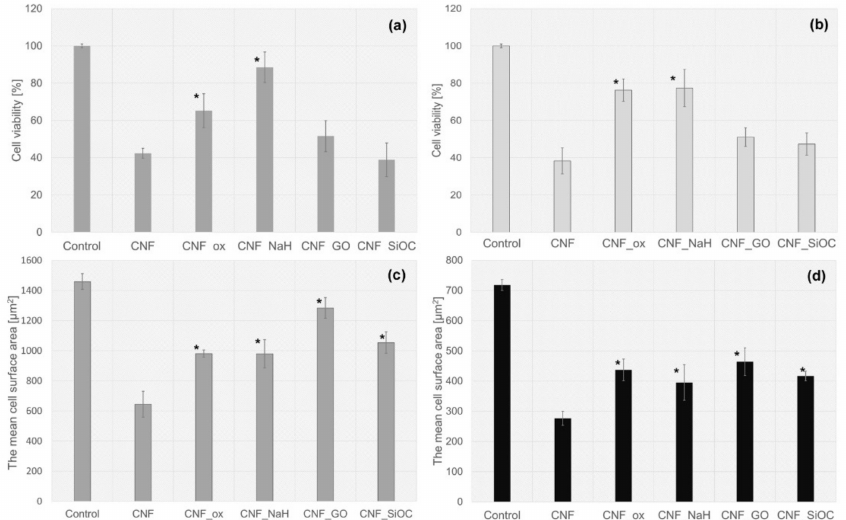
Figure 9. Viability of ( a ) osteoblast-like (MG-63) cells and ( c ) human chondrocyte (CHON-001) cells in contact with CNF before and after surface modification. The average MG-63 ( b ) and CHON-001 cells ( d ) surface area in contact with materials. The Mann-Whitney U test for multi comparison was used to assess statistical significance at * p ≤ 0.05 vs. as-received CNF.